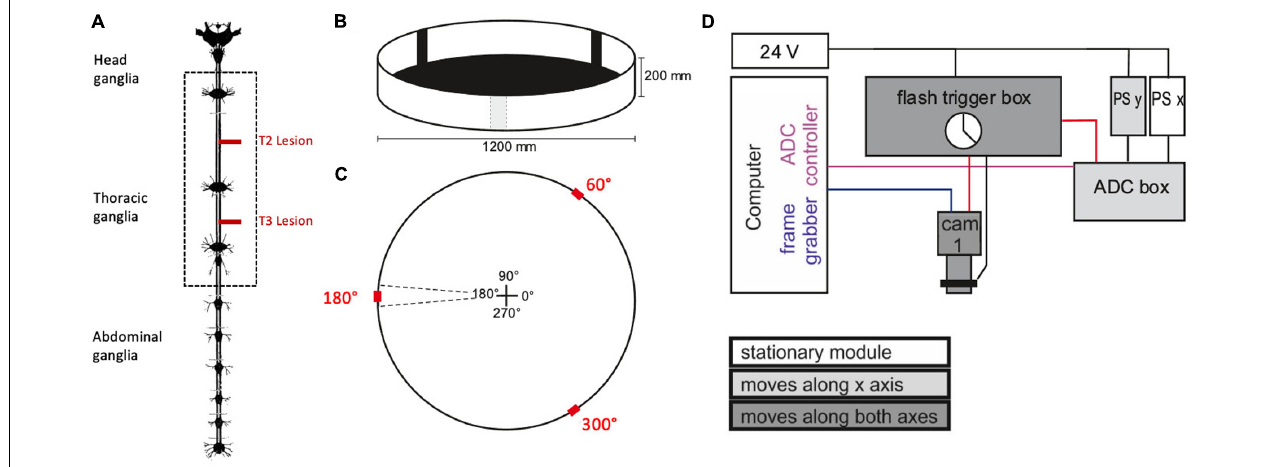
FIGURE 1 | Experimental procedure. (A) Nervous system of the stick insect. The dotted box contains the ventral nerve cord ganglia of the thoracic segments (adapted from Marquardt, 1939; the distance between the meso- and meta-thoracic ganglion is approximately 12 mm in adult female C. morosu s). For the operation, the right connective was severed either between pro- and mesothoracic ganglion or between the meso- and metathoracic ganglion (T2 and T3 lesion, respectively, red lines). In the sham operations the corresponding connective was touched with a pair of tweezers. (B) Animals walked freely in a planar circular arena containing three visual landmarks (black bars) of 10 ◦ width. (C) Schematic top view of the arena, indicating location and size of the landmarks (red) in relation to the initial walking directions (central cross). (D) Schematic wiring diagram of the gantry system for manual two-axis tracking of animals walking within the arena. The camera was mounted to a small sleigh that could be sled along a second, larger sleigh that, in turn, sled along rails on the main frame. The movement of both sleighs was monitored by linear position sensors (PS). The computer ran two programmes that registered the data streams from the camera (blue line: Firewire connection) and the two PS via an analogue-to-digital converter box (ADC box; purple line: USB2 connection. Black lines indicate analogue signals. The clock of the flash trigger box synchronised the cameras, the infrared flashlights, and the ADC box (red lines: TTL